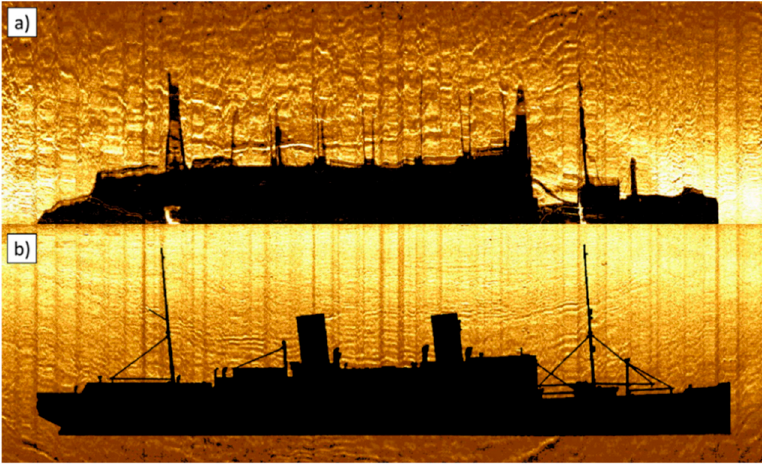
Figure 12. Comparison of the acoustic shadow shape with the ship's silhouette. ( a ) hydroacoustic Figure 11. Examples of the wrecks with protruding, vertical structural elements. ( a ) yacht wreck; ( b ) shadow from the sonogram of the shipwreck and ( b ) black silhouette of the ship General von Steuben barge with piles of wood; ( c ) fishing boat; and ( d ) barge. for comparative analysis.